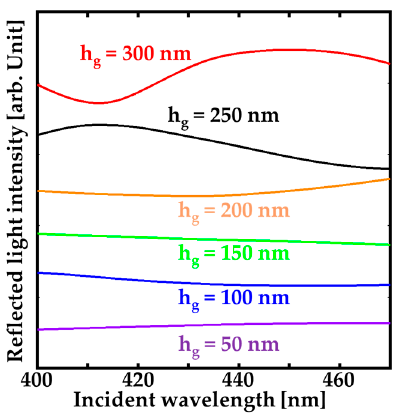
Figure 9. FDTD calculated reflection spectrum of GaN-HCG with Λ = 200, w = 180 nm, and h g = 50 to 300 nm.